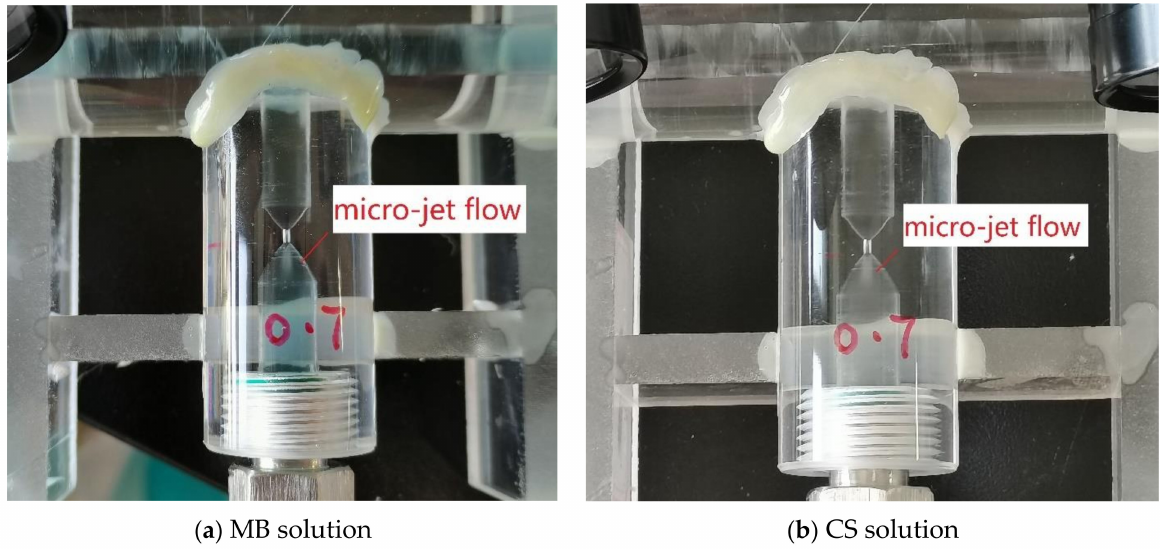
Figure 3. Images of fluids flowing through the venturi (the images taken under the operation condition: throat diameter, 0.7 mm; inlet pressure, 0.4